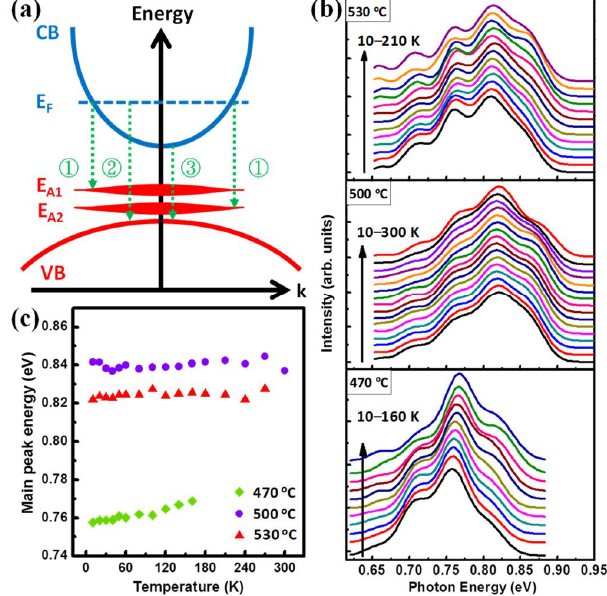
Figure 5. ( a ) Schematic of the recombination of an electron with hole in the InN samples. (1) Electron at Fermi edge recombines with localized hole at acceptor. (2) Electron recombines with hole at valence band. (3) Near-band-edge transition. ( b ) Temperature-dependent PL spectra of the InN samples. ( c ) The temperature-dependent main peak energy.